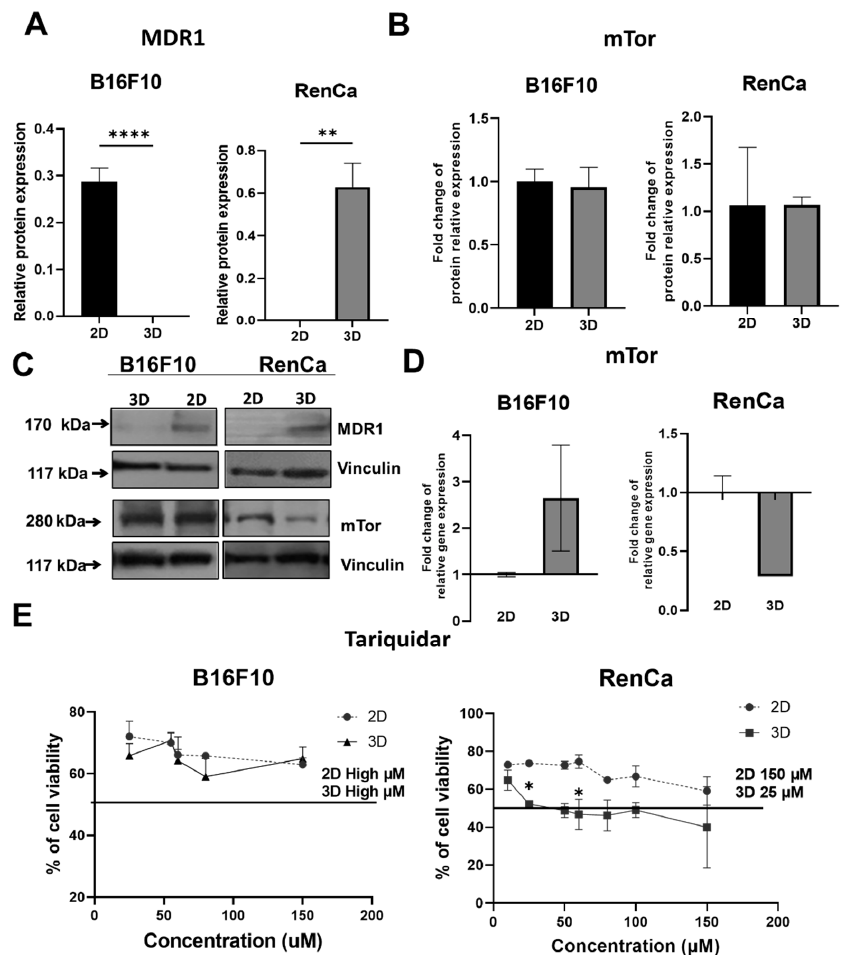
Figure 4. Regulation of MDR1 and mTor expression. ( A )—Relative to 2D protein expression of MDR1 of melanoma and renal cancer cells, Vinculin served as loading control. ( B )—Relative to 2D protein expression of mTor of melanoma and renal cancer cells, Vinculin served as loading control. ( C )—Detection of MDR1 and mTor by western blot. ( D )—The gene expression of mtor was determined by quantitative RT-PCR (qRT-PCR); β -actin served as an internal control. ( E )—Sensitivity to tariquidar in various concentrations estimated by Alamar blue assay—( D ). Statistical analyses were performed by One-Way NOVA/Tukey test or Kruskal–Wallis/ Dunn’s test—* p < 0.05, ** p < 0.0021, **** p < 0.0001, N ≥ 3